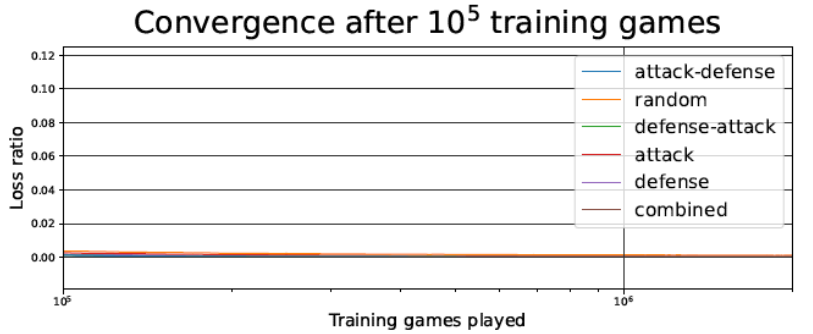
Figure 11. Connect-4 TD agent loss ratio after 100,000 games as a function of the number of games played, for the different training strategies.